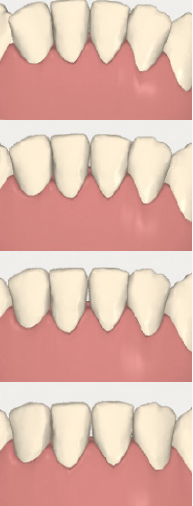
Figure 9. Case 1: photos after the surgical procedure; sutures with Vicryl 5.0 thread were applied only where bleeding persisted.